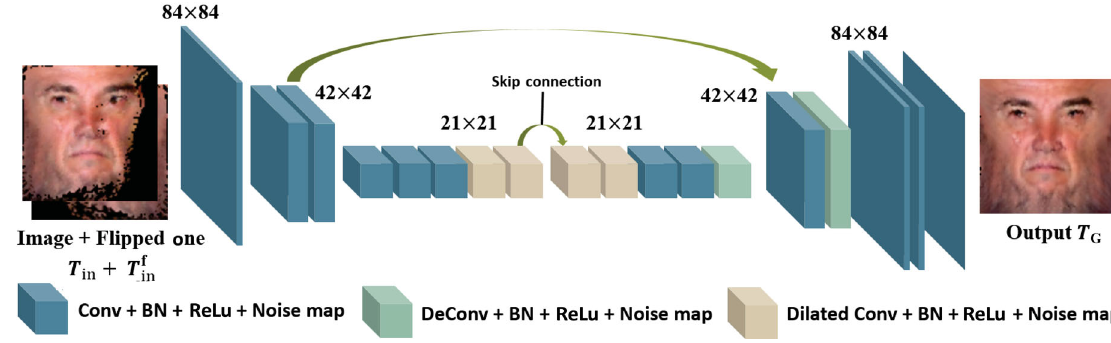
Fig. 3 Architecture of the I-Net